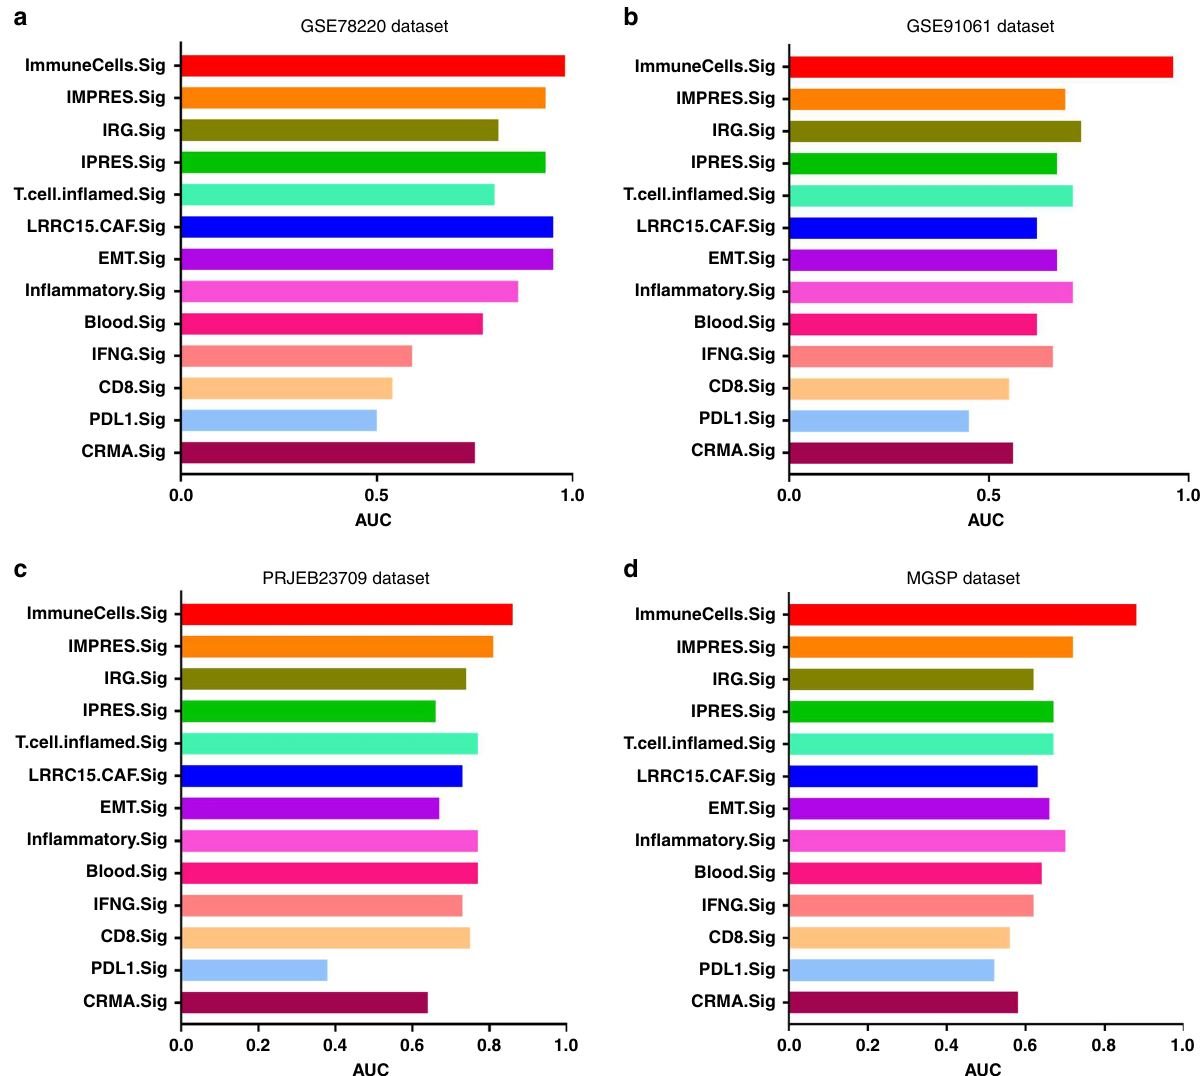
Fig. 5 Comparison of the performance of ImmuneCells.Sig with other ICT response signatures. The multiple barplots for the AUC values of the 13 ICT response signatures are shown in a for the GSE78220 dataset. b for the GSE91061 dataset. c for the PRJEB23709 dataset. d for the MGSP